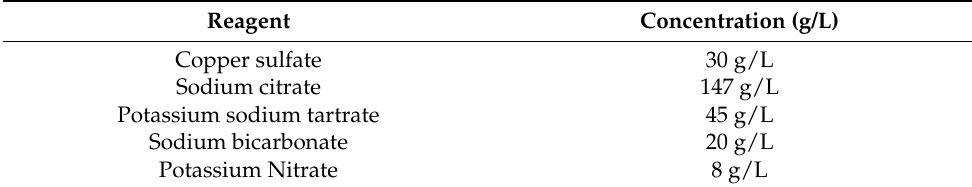
Table 3. Component of electrodeposition